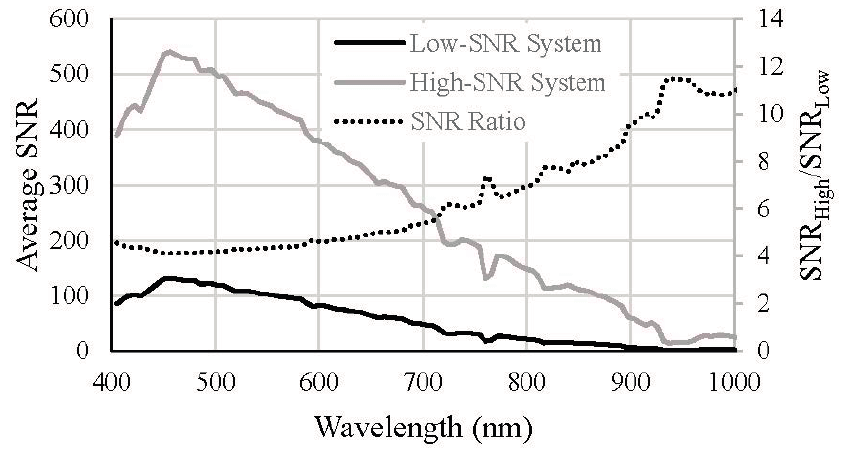
Figure 2. The average SNR calculated from the at-sensor radiances (of all 490 images) for the low- and high-SNR systems. The ratio of the average SNR for the high-SNR system to that for the low-SNR system is plotted on the secondary